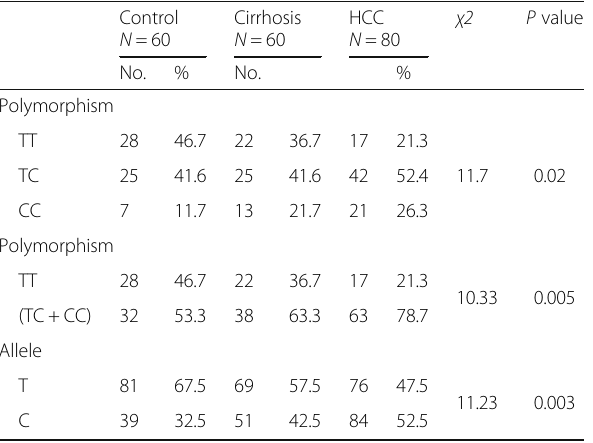
Table 3 Distribution of the genotypes and allele frequencies in three studied groups